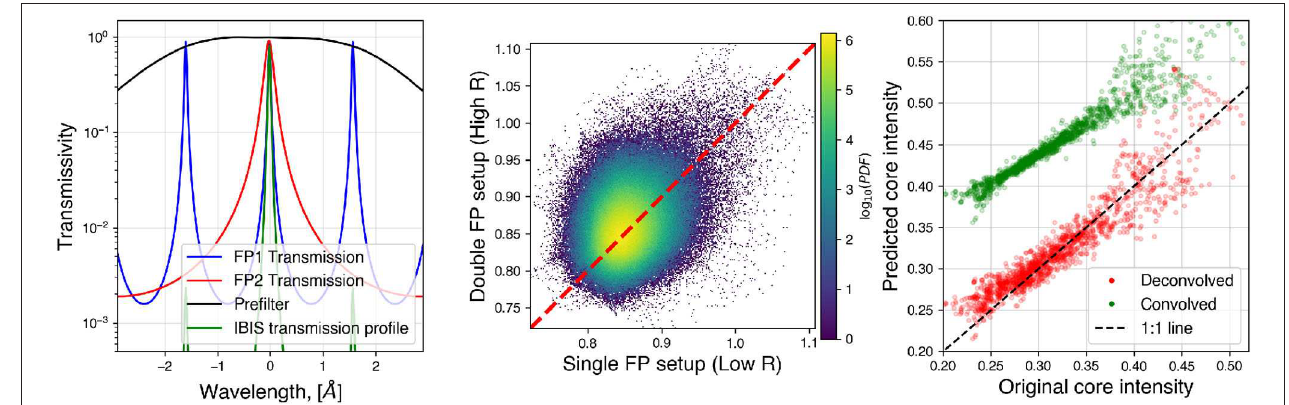
FIGURE 3 | (Left) Transmission profile of the components of the IBIS Instrument centered around 8,542 Å. The transmission profiles of the two Fabry-Pérot etalons are in red and blue; the 8,542 Å prefilter profile is the black line; The effective transmission profile of the instrument is presented in green; (Center) Histogram of the wing intensity in the data sets with single FP (low R) and both FPs (high R) in the optical system; (Right) The result of the deconvolution algorithm applied to real IBIS data (same as top right panel in Figure 2 ) for the line core intensity.